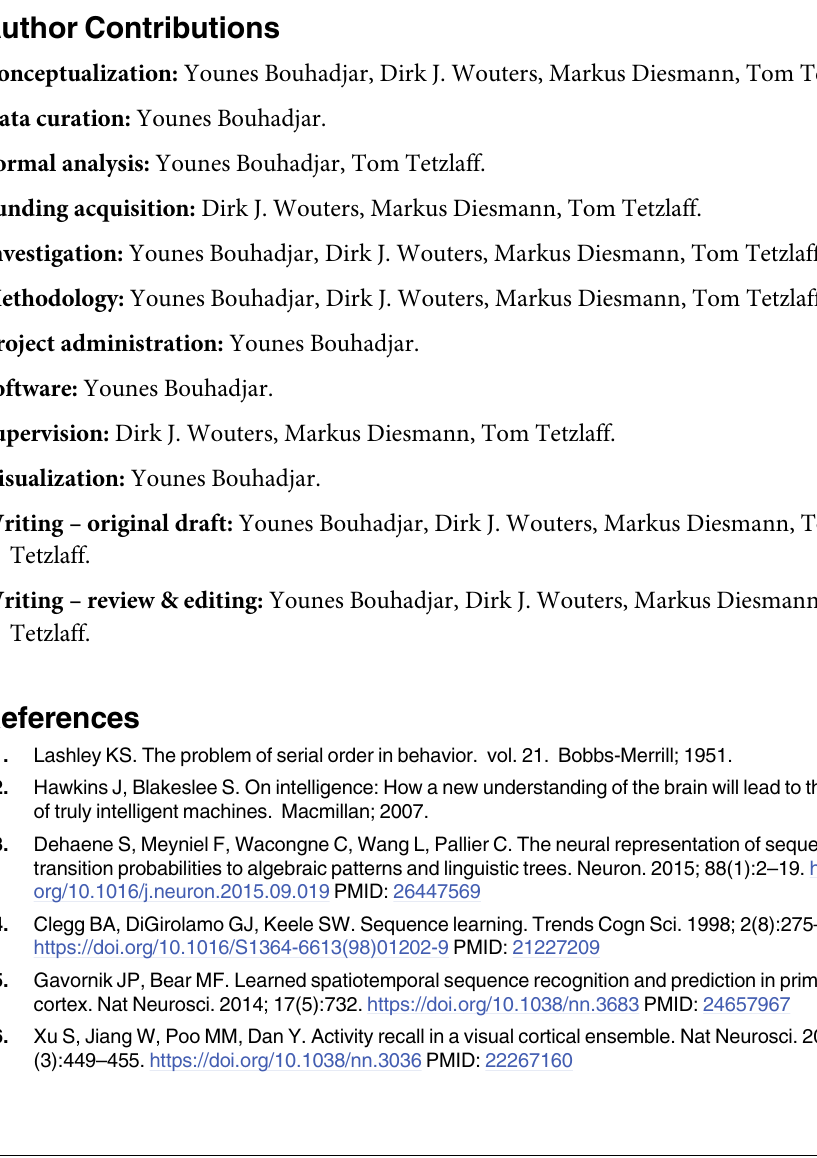
{F, D, B, C} is presented once (black arrows in the top panel). Top panel : Red dots and blue bars mark spike and dAP times for each neuron. Neurons are sorted according to stimulus preference (vertical axis). Bottom panel : Network connectivity before learning (left) and dur- ing the current training episode (right). Light gray and black dots represent immature and mature connections, respectively, for each pair of source and target neurons (sorted according to stimulus preference; see Sequence learning and